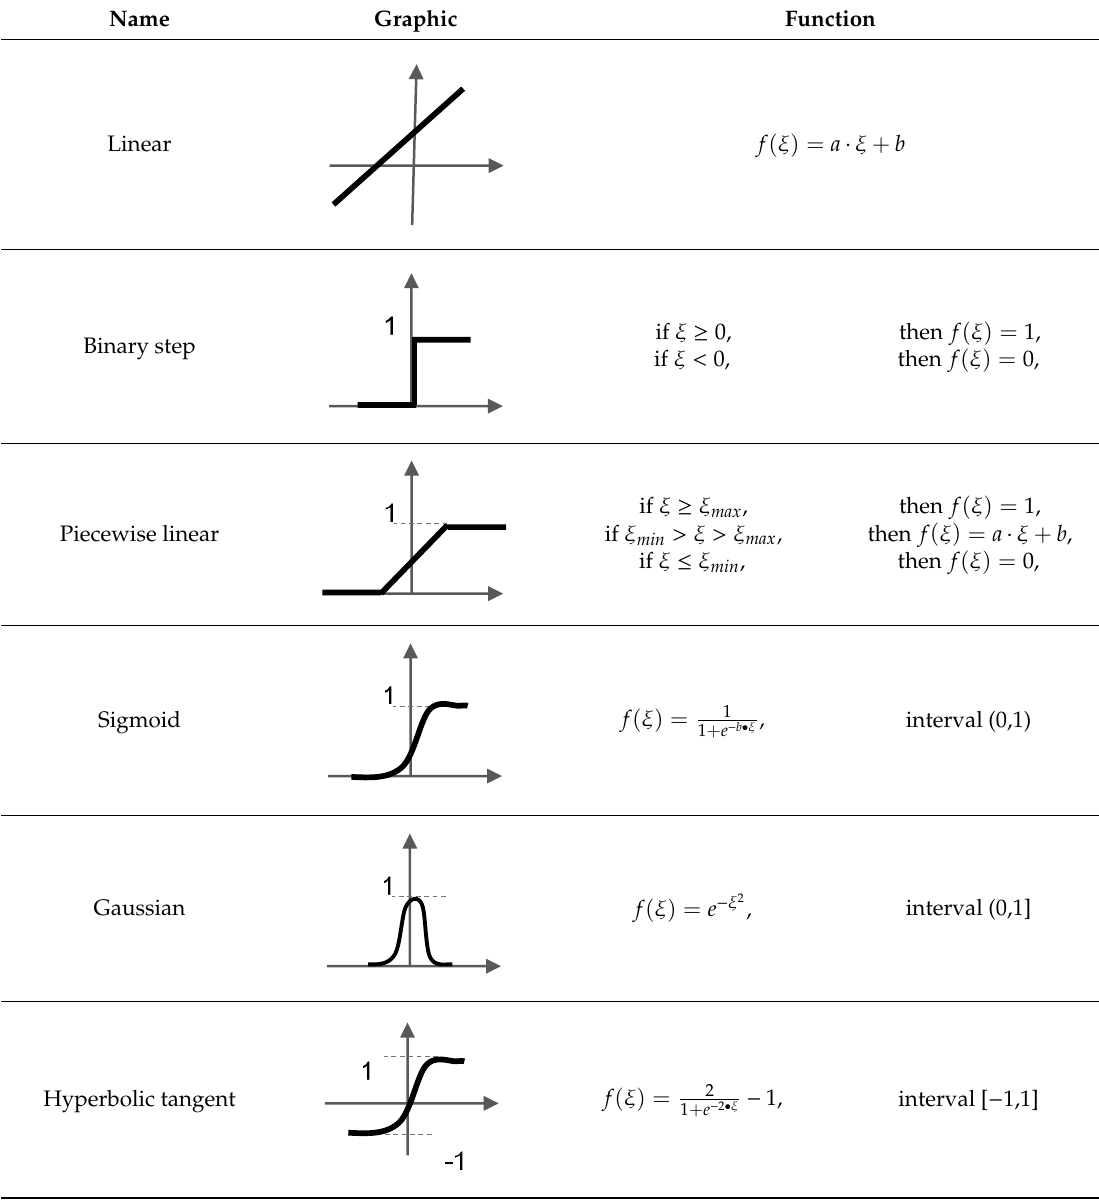
Table 1. Activation functions for layers in artificial neural networks.